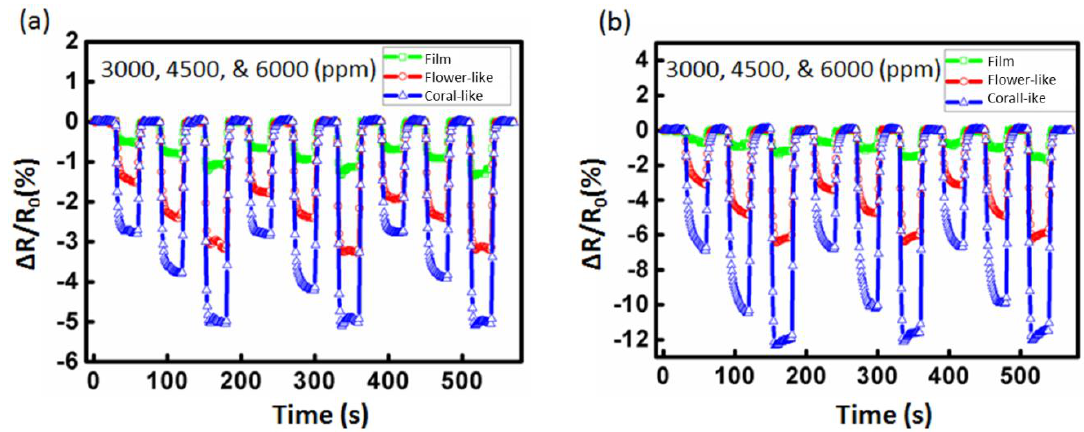
Figure 7. Sensitivity (ΔR/R 0 ) curves of the detector for different concentrations of toluene gas: ( a ) non-photoactivated and ( b ) photoactivated with 2 μW/cm 2 UV illumination.